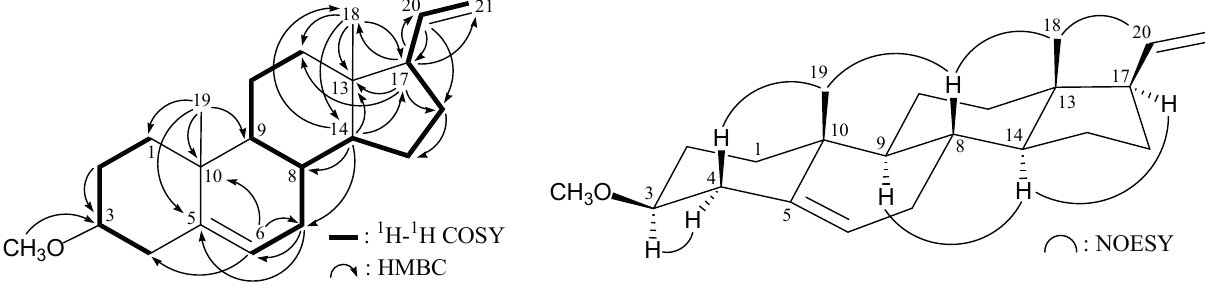
Figure 1. Selective key 1 H– 1 H correlation spectroscopy (COSY), heteronuclear multiple-bond